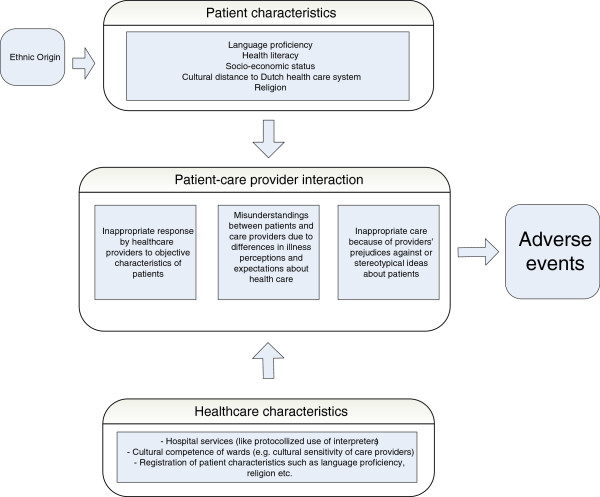
Conceptual model.